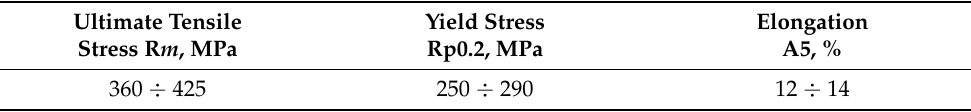
Table 2. Mechanical properties of the EN AW-2024-T3 aluminum alloy [31].